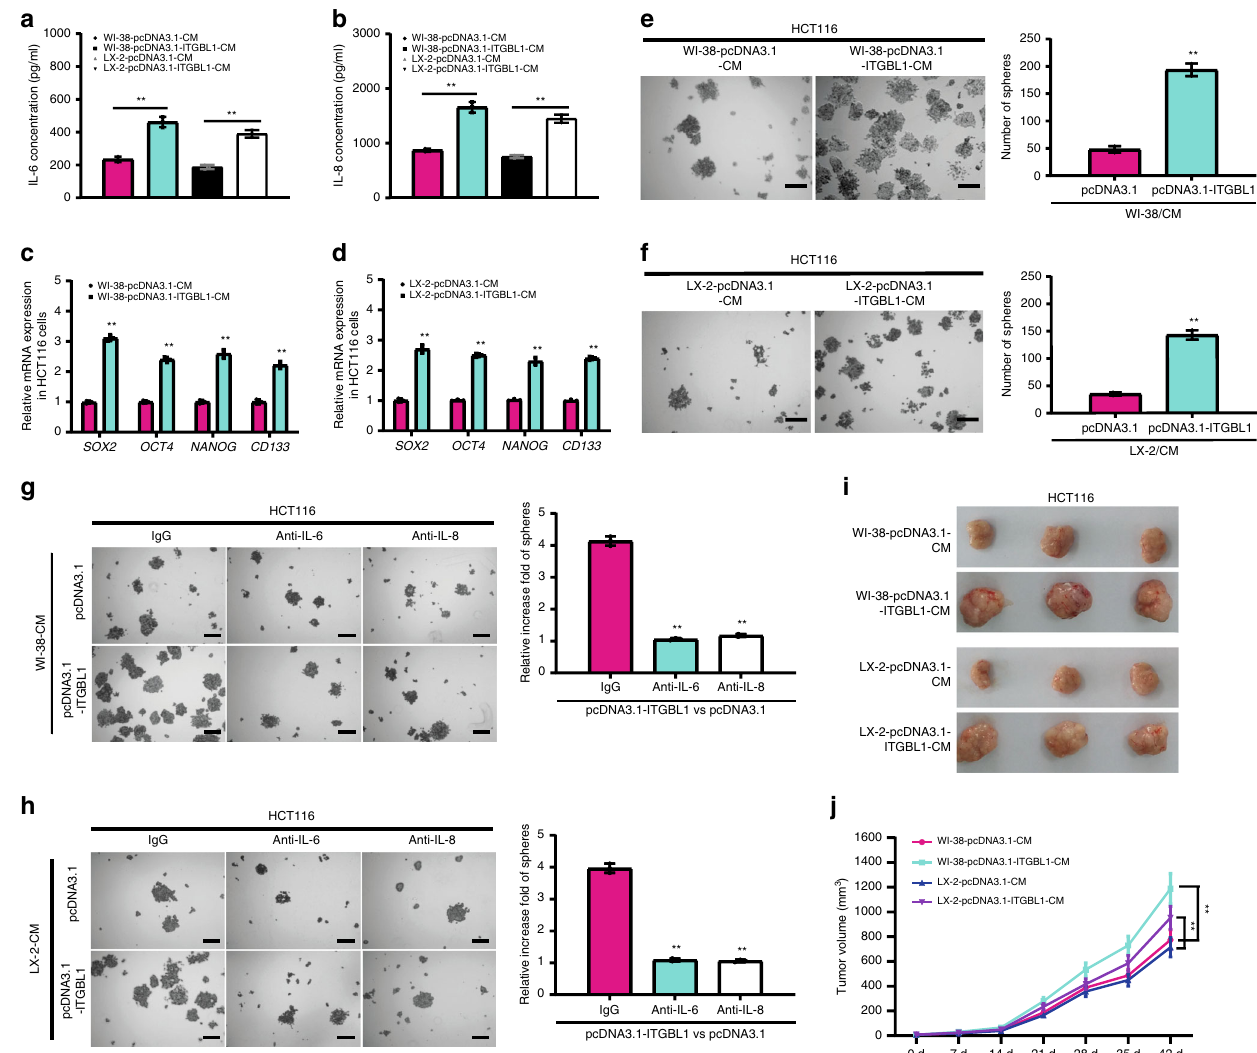
Fig. 7 Activated fi broblasts by ITGBL1-enriched EVs promoted the stemness and tumorigenicity of CRC. a , b ELISA assays of the IL-6 and IL-8 secretion from ITGBL1-overexpressing WI-38 and LX-2 cells, or control cells. c , d qRT-PCR analysis of stemness-associated genes expression in HCT116 cells treated with indicated conditioned medium (CM) from ITGBL1-overexpressing WI-38 and LX-2 cells, or control cells. e , f Spheroid formation ability of HCT116 cells treated with indicated CM from ITGBL1-overexpressing WI-38 and LX-2 cells, or control cells. Representative images were shown and spheroids were counted. Scale bar, 150 μ m. g , h Relative spheroid formation ability of HCT116 cells treated with indicated CM containing anti-IL-6 antibody or anti-IL-8 antibody or control IgG antibody. Representative images and relative quanti fi cation were shown. Scale bar, 150 μ m. i , j Xenografts of HCT116 cells with indicated treatments performed on nude mice. HCT116 cells were pretreated with the CM from ITGBL1-overexpressing WI-38 and LX-2 cells, or control cells. Length and width of the subcutaneous tumors were measured every 7 days. For each group, three mice were used for quanti fi cation. Each experiment was performed at least in triplicate and all the data are shown as mean ± SD. Student ’ s t -test was used to analyze the data; * p < 0.05, ** p < the Ethical Committee of Shuguang Hospital, Shanghai University of Traditional Chinese Medicine, and Fudan University Shanghai Cancer Center. Written informed consent was obtained from all patients before the start of the study.